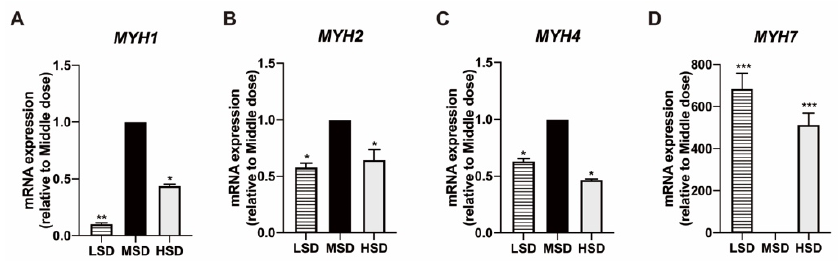
Figure 7. Effect of feeding density on muscle function of Kunming mice. ( A ) qPCR analysis was performed to assess the mRNA abundance of MYH1 in mice of different feeding density. ( B ) qPCR analysis was performed to assess the mRNA abundance of MYH2 in mice of different feeding den- sity. ( C ) qPCR analysis was performed to assess the mRNA abundance of MYH4 in mice of different feeding density. ( D ) qPCR analysis was performed to assess the mRNA abundance of MYH7 in mice of different feeding density. Data were presented as a mean ± SD, n = 3, * p < 0.05, * * p < 0.01, *** p < 0.001, vs. MSD group.